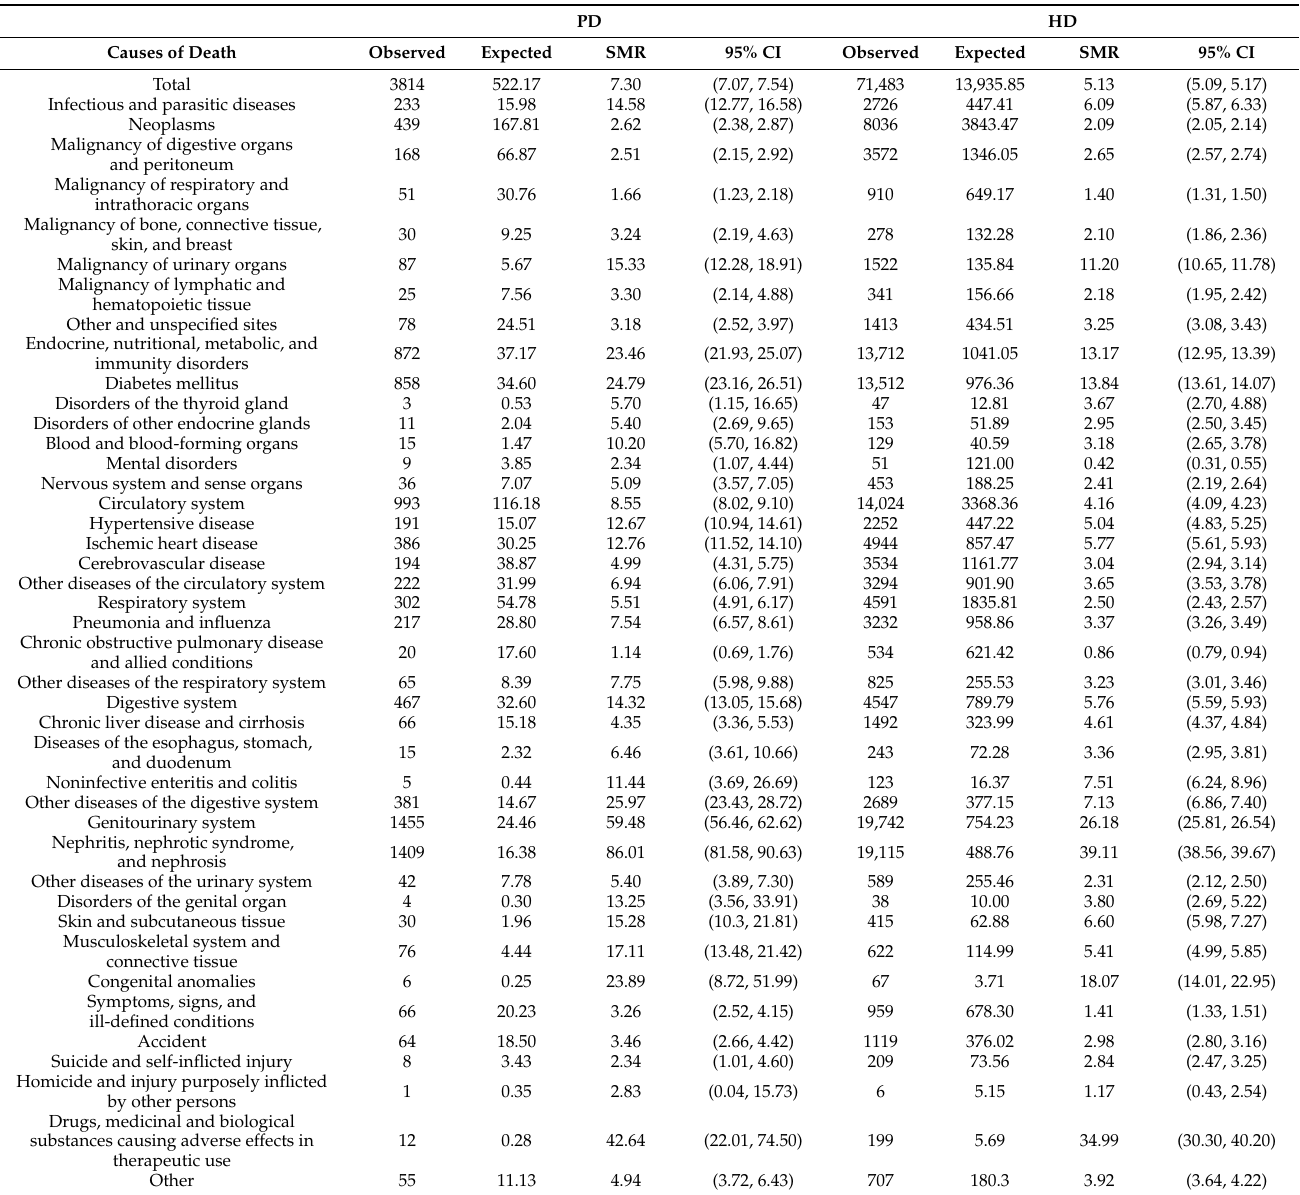
Table 3. All-cause standardized mortality ratio (SMR) of peritoneal dialysis (PD) and hemodialysis